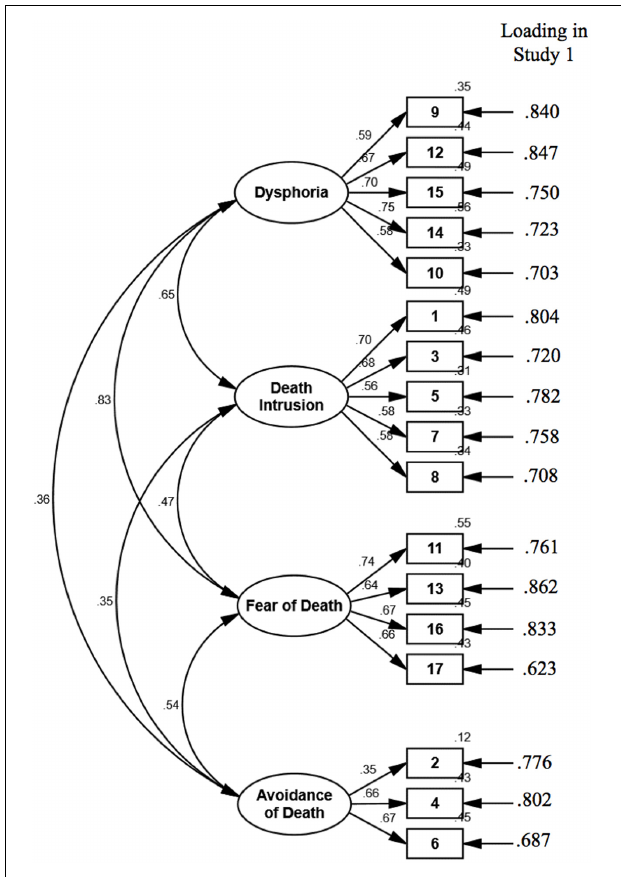
FIGURE 1 | Confirmatory factor analysis in Study 2, and rotated (promax) factor loadings in Study 1 with principal component